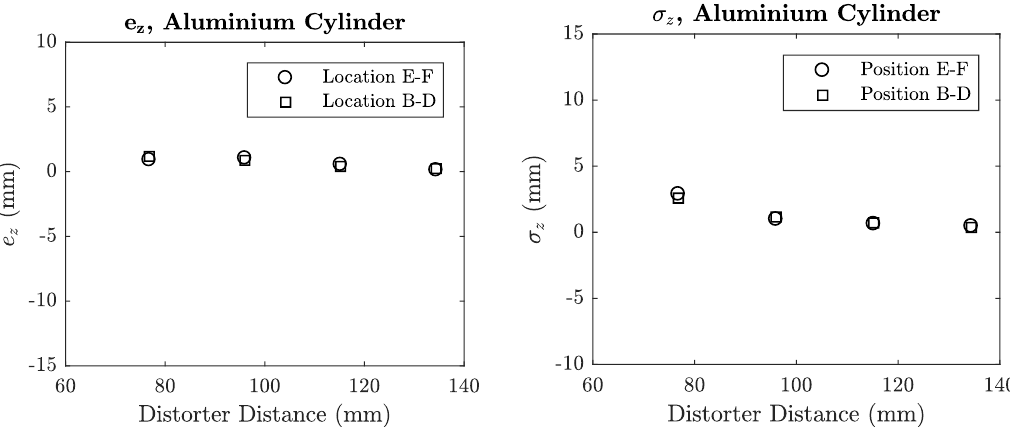
Figure A13. Position error plots for aluminium section in locations A, B and C. Location B causes the highest positioning error and standard deviation as the aluminium section is placed directly below transmitter coil 4.